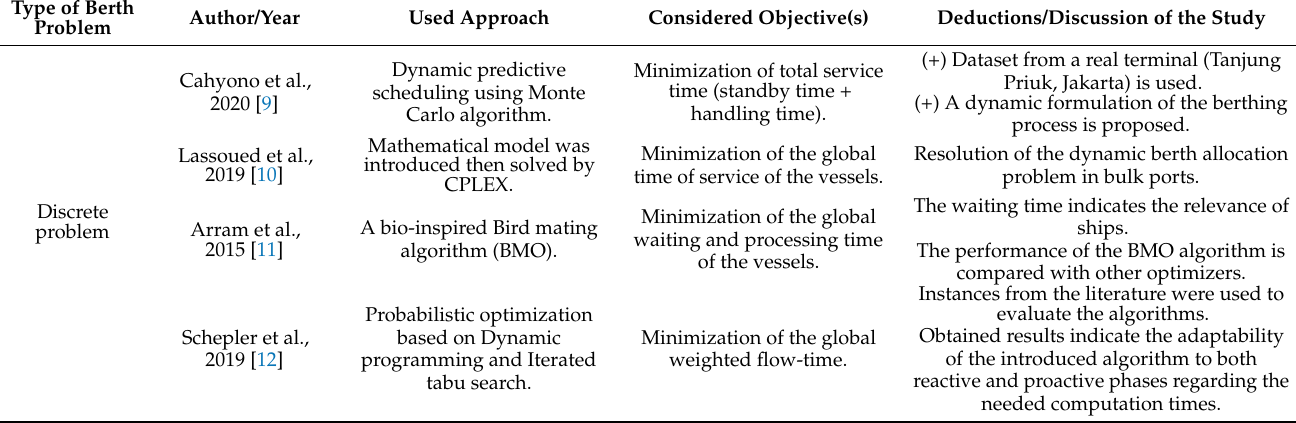
Table 1. Illustration and discussion of relevant studies investigating the berth planning